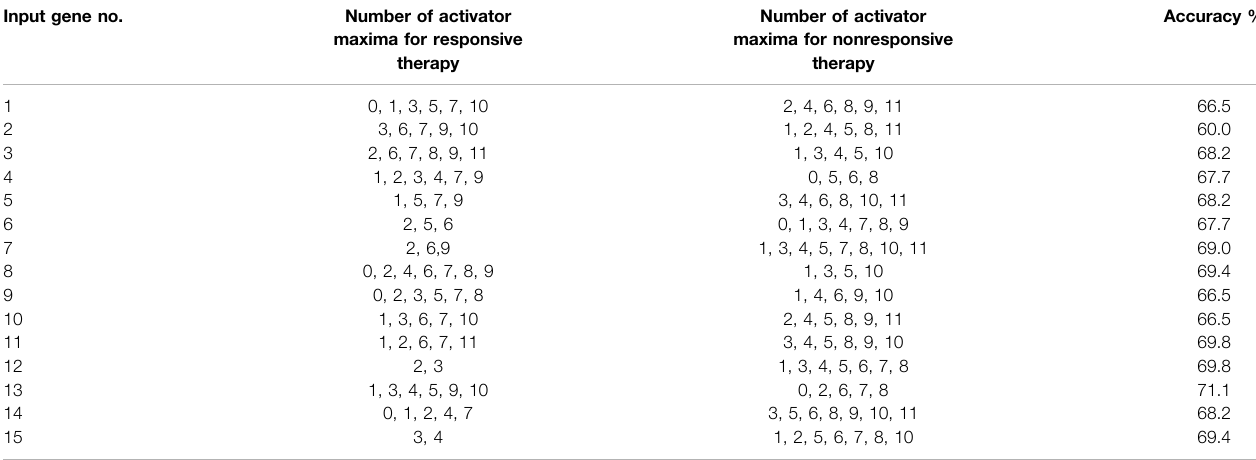
TABLE 4 | The rules that translate the number of activator maxima on the output oscillator and the effective therapy using bortezomib or dexamethasone drugs. Input gene